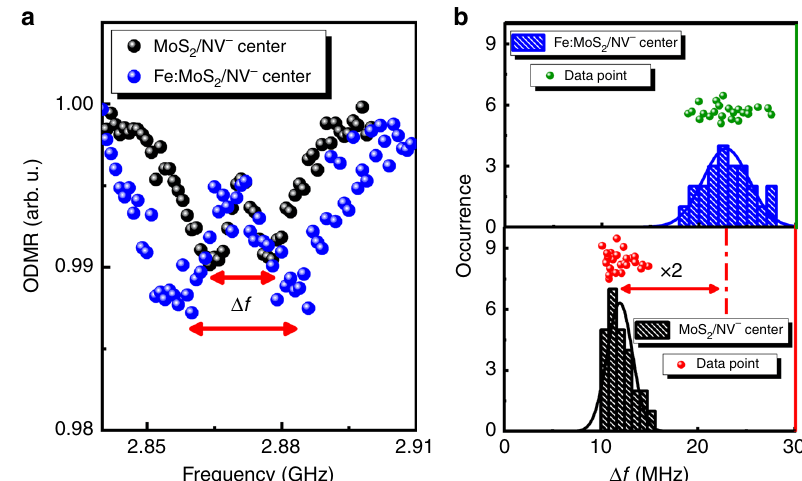
Fig. 5 Local magnetic fi eld of Fe:MoS 2 monolayers. a Comparison of ODMR spectrum of the NV − centers coated on as-grown MoS 2 and Fe:MoS 2 monolayers, respectively, demonstrating additional Zeeman splitting due to Fe:MoS 2 local magnetic fi eld. b Corresponding occurrence histograms for NV − centers frequency splitting between the two spin sublevels, recorded at room